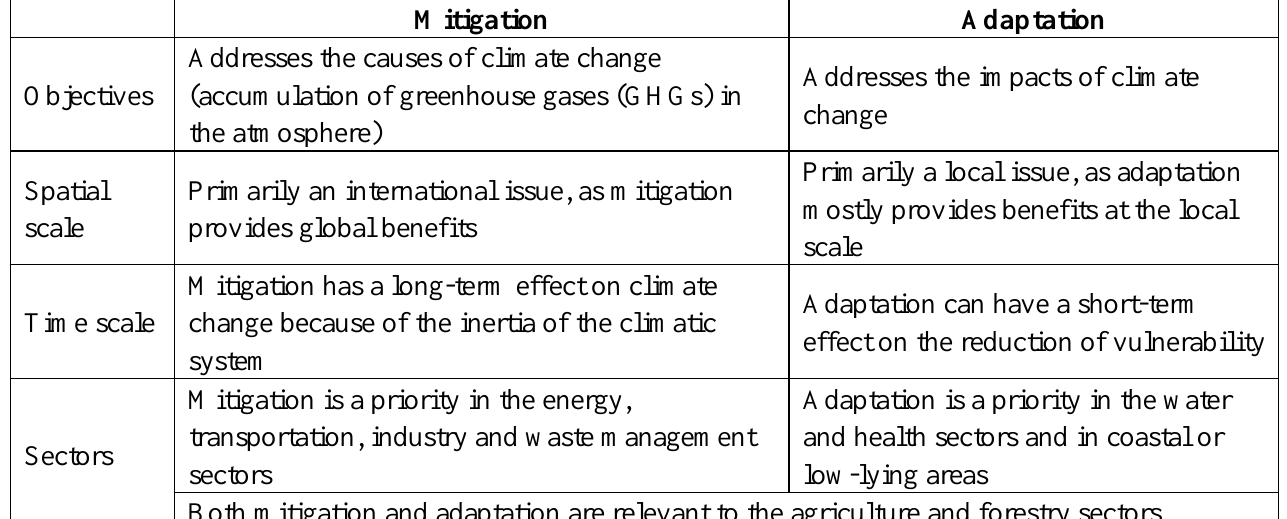
Table 1. Main differences between adaptation and mitigation (from